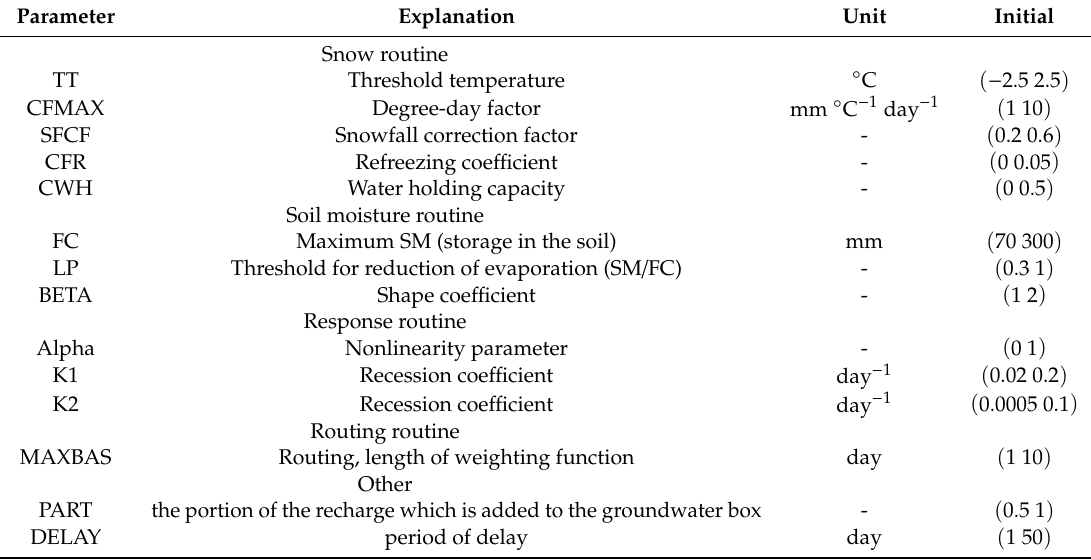
Table A1. HBV model parameters and the value ranges (DELAY response